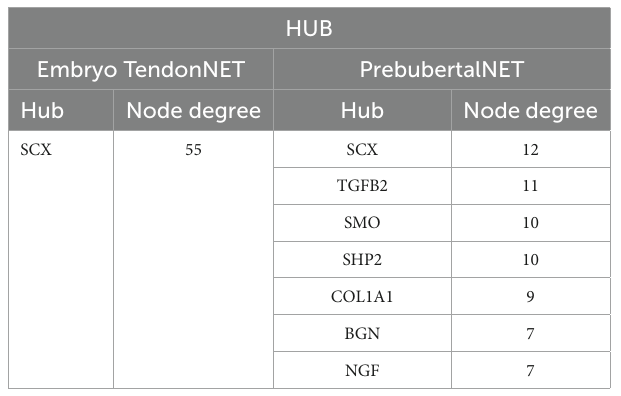
TABLE 3 Hub molecule identification and ranking in embryo TendonNET and prepubertal